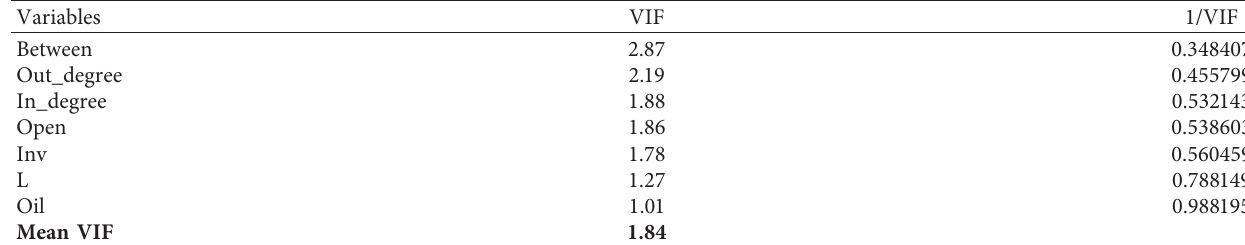
Table 3: Test for multicollinearity between independent variables.